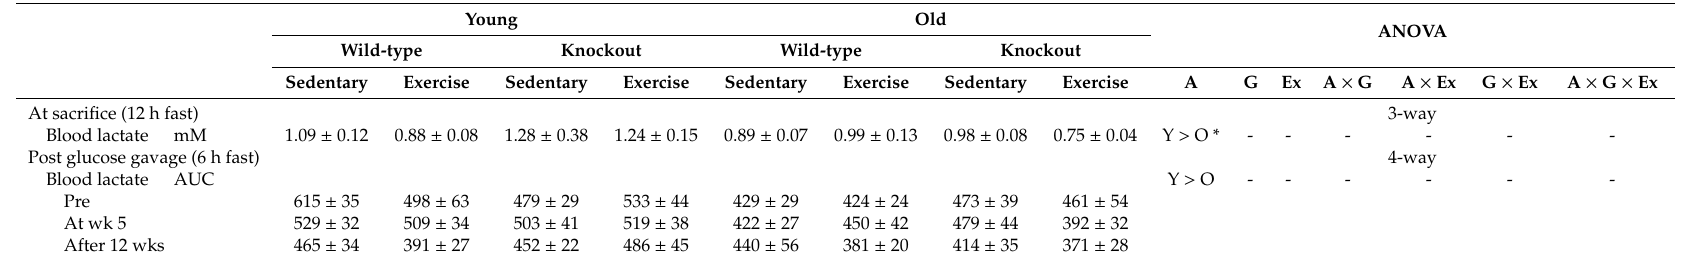
Table 2. Fasting and post glucose–gavage blood lactate